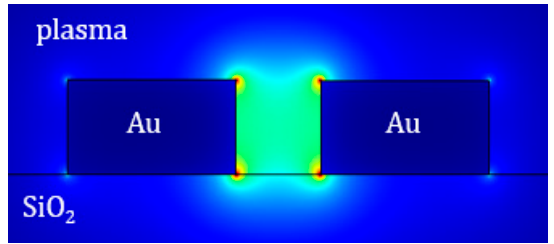
Figure 5. Electric field distribution for the quasi-TEM mode supported by the plasmonic slotted waveguide with w s = 90 nm and h = 100 nm.